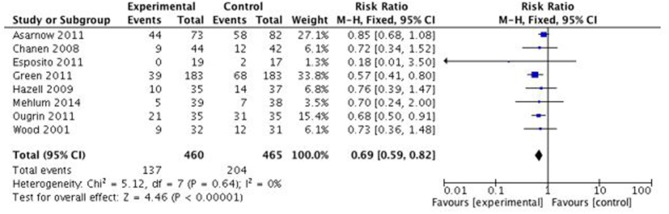
Effects of specific psychological treatment (SPT) vs. treatment as usual (TAU) on treatment engagement in self-harming adolescents (Studies with Jaded score >2). M-H = Mantel-Haenszel.